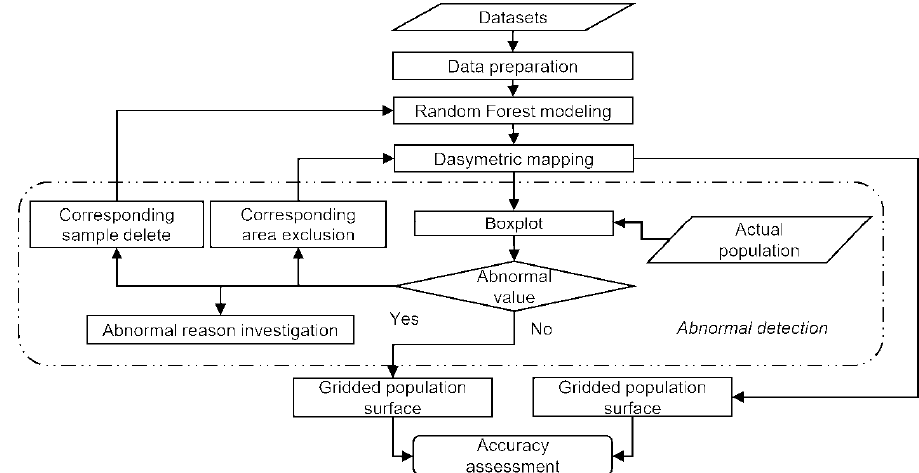
Figure 3. Relationship between abnormal detection and our approach of population mapping.